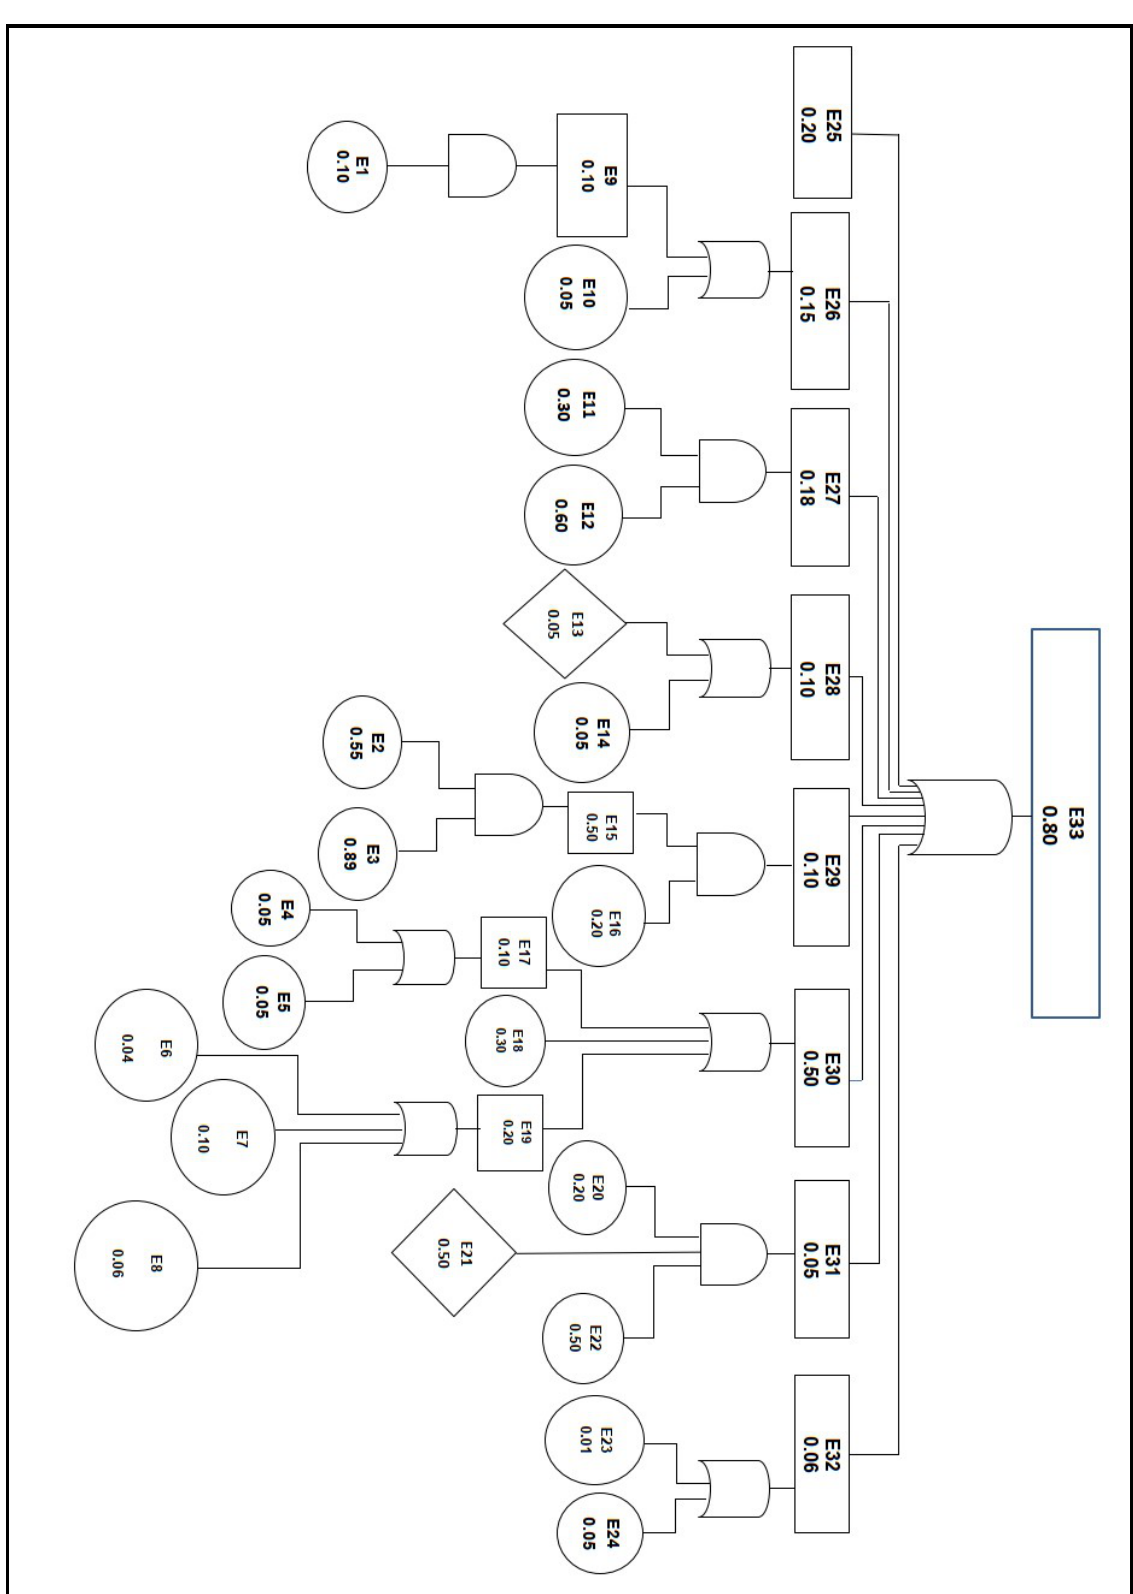
Fig. 5. Fault tree analysis with the